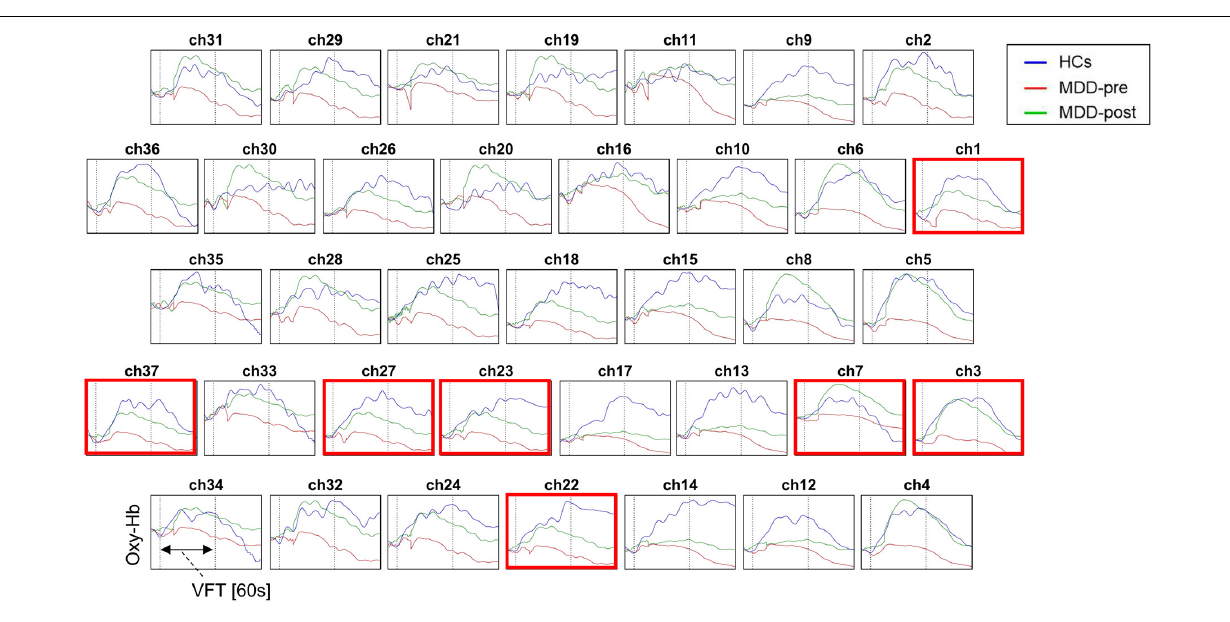
FIGURE 4 | Waveforms of [oxy-Hb] values during the VFT in the 37 channels over prefrontal regions in patients with MDD before (pre) and after (post) rTMS treatment and HCs. Red box indicates significant increase in [oxy-Hb] value from baseline to post-treatment in patients with MDD in this